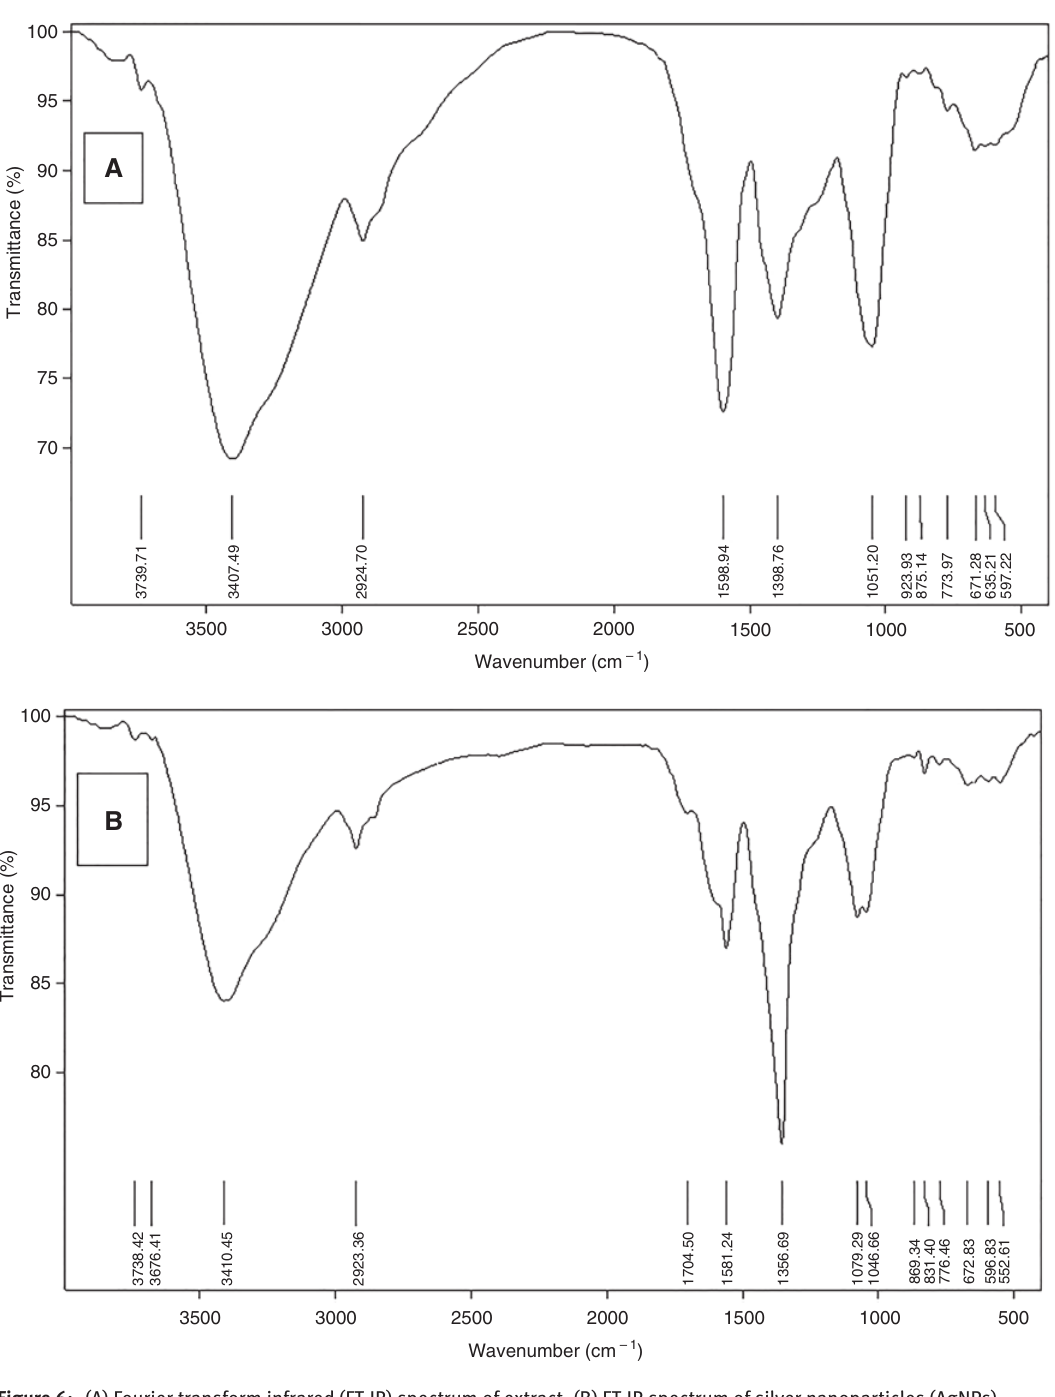
Figure 6: (A) Fourier transform infrared (FT-IR) spectrum of extract. (B) FT-IR spectrum of silver nanoparticles